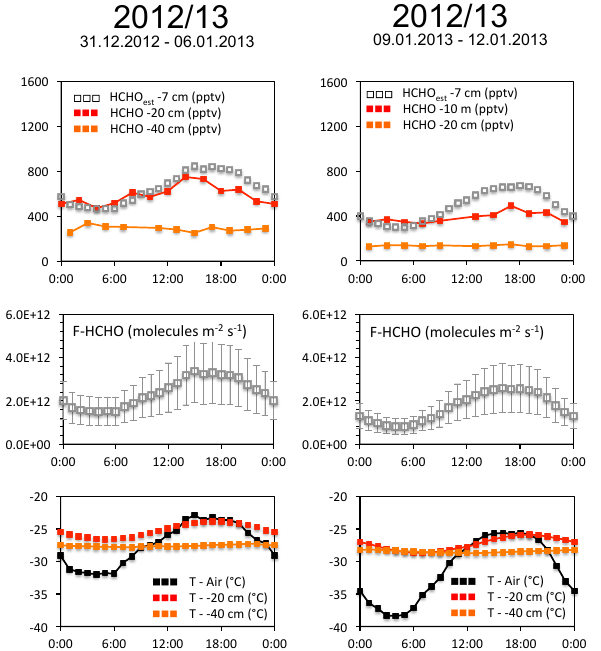
Figure 6. Top: mean daily course (hours are LT) of firn air HCHO mixing ratios at different depths. At 7cm below the snow surface, HCHO mixing ratios were estimated. Second from top: HCHO flux calculated from firn air atmosphere gradients. Error bars re- fer to uncertainties in depth ( ± 3cm) and in snow concentration ( ± 0.08ppbw) (see text in Sect. 3.3). Bottom: air and firn air tem- peratures.